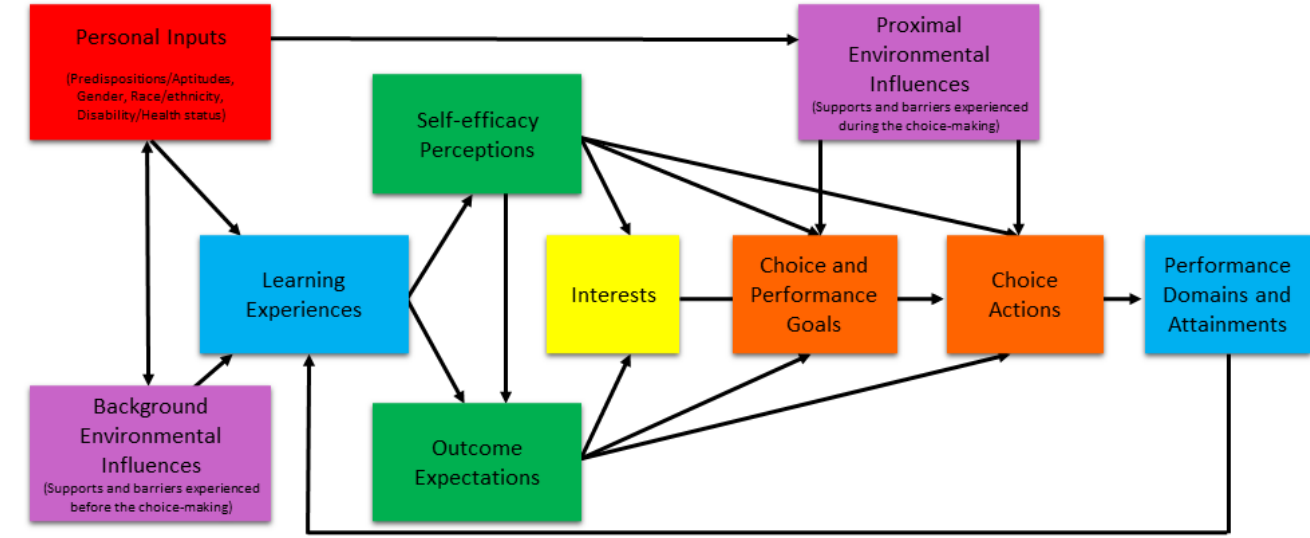
Figure 1. Social Career Cognitive Theory (Lent et al. 1994).